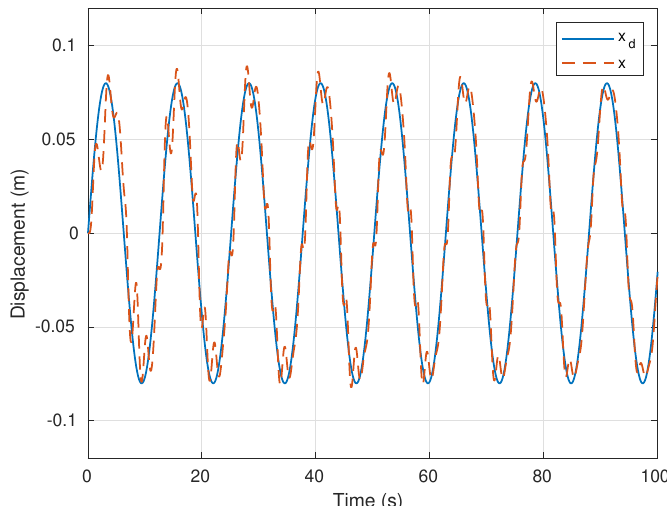
Figure 11. Sinusoidal wave trajectory tracking performance with CMAC.